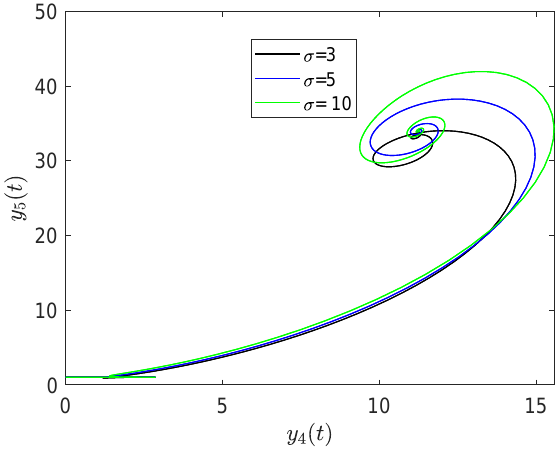
Figure 54. Phase portraits of y 4 and y 5 when varying σ